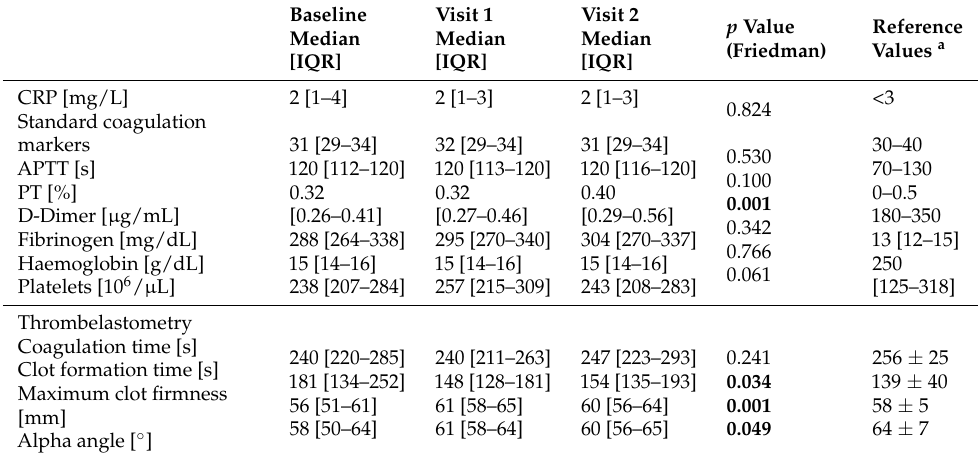
Table 3. Coagulation markers pre- and post-vaccination in T2DM patients. Data are expressed as me- dian and IQR. p Values were calculated by means of the Friedman test ( n = 37). Abbreviations: APTT, activated partial thromboplastin time; PT, prothrombin time. a see references [11,14]; b reference values do not